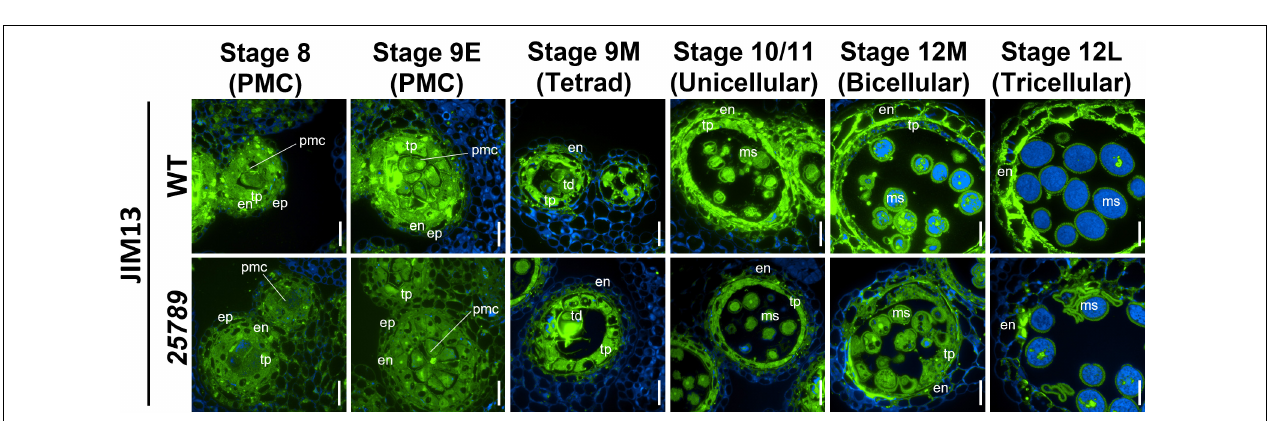
FIGURE 5 | TEM images of WT and galt25789 mutant microspores. (A) Microspores from WT plants. Exine, Intine, and pollen coat of pollen grains (tricellular stage) at stage 12L. (B) Microspores from galt25789 mutant plants. Intine is thin and membrane blebbing is evident in galt25789 mutant normal microspores (indicated by red arrows). (C) Abnormal pollen wall patterning is visible in the aborted mature pollen stage. The mature aborted pollen grain wall structure is aberrant. The pollen grain gets devoid of any content and nuclei. Intine layers are virtually absent (marked by red arrow), and a very dark cytoplasm marks the degradation of the cytoplasm. ba, baculum; ex, exine; in, intine; te, tectum; pc-pollen coat. Scale bars = 5 µ m; 3 µ m; 2 µ m; 500 nm as indicated.